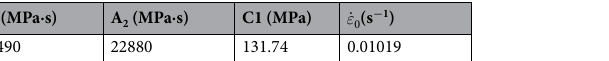
Table 1. Strain rate dependent material parameters of mean elastic modulus of collagen fibrils fitted using obtained experimental